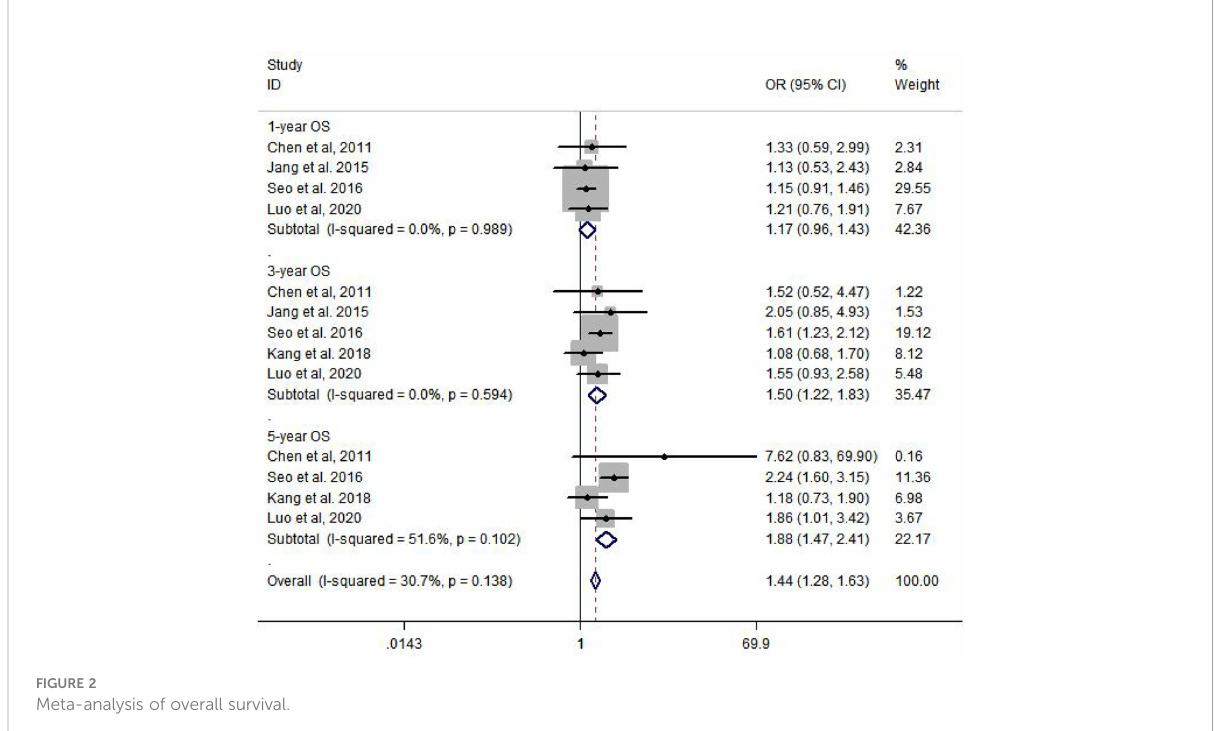
FIGURE 2 Meta-analysis of overall survival.